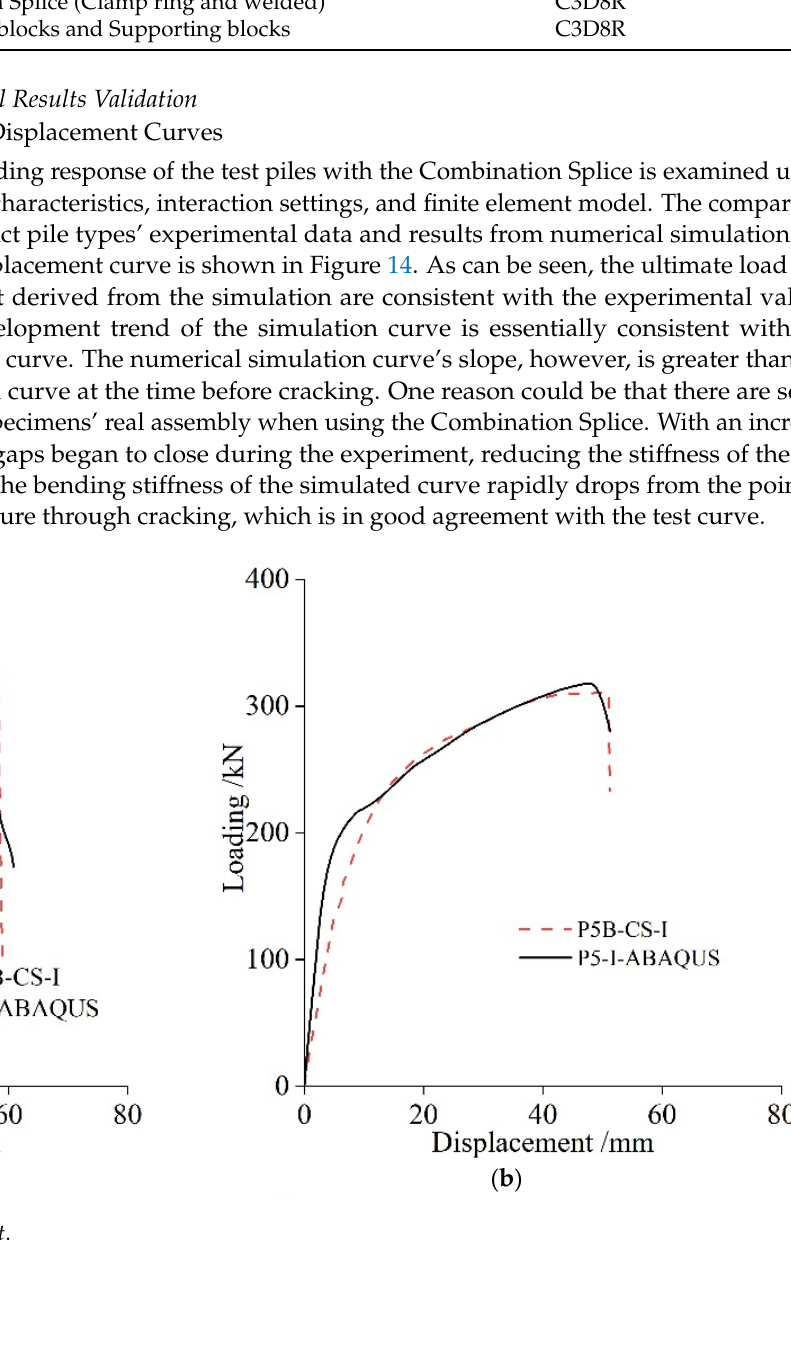
( d ) Figure 14. Comparison of load–displacement curves between FEA and experimental results: ( a ) P4B-CS-I, ( b ) P5B-CS-I, ( c ) P5C-CS-II, ( d ) P6A-CS-I. 5.4.2. Crack Distribution Cracks are expected to form when the maximum principle plastic strain of concrete is positive in the CDP concrete material model, and the direction of the cracks may be observed using the maximum principal plastic strain [9]. In this numerical simulation, the development of cracks in piles is described by the maximum principal plastic strain of concrete rather than tensile damage. When the ultimate bending capacity is attained, Fig- ure 15 illustrates a comparison of the fracture distribution between computational and experimental data. It can be shown that the crack development generated from the nu- merical model, including the distribution and evolution of the fracture area, is compatible with the experimental data.